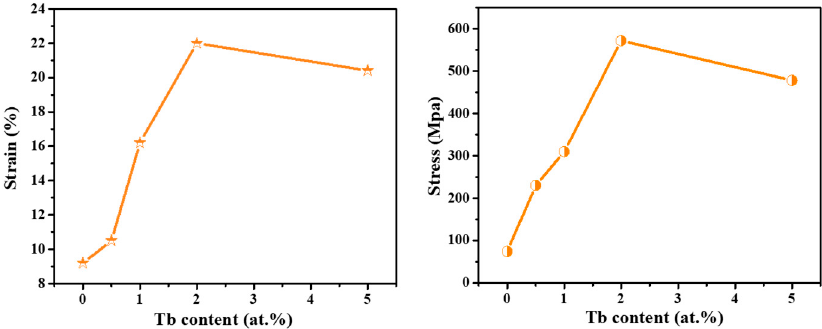
Figure 7. The effect of Tb content on the compressive strength and the compressive strain of Ni 48 Mn 39 Sn 13 − x Tb x alloys.